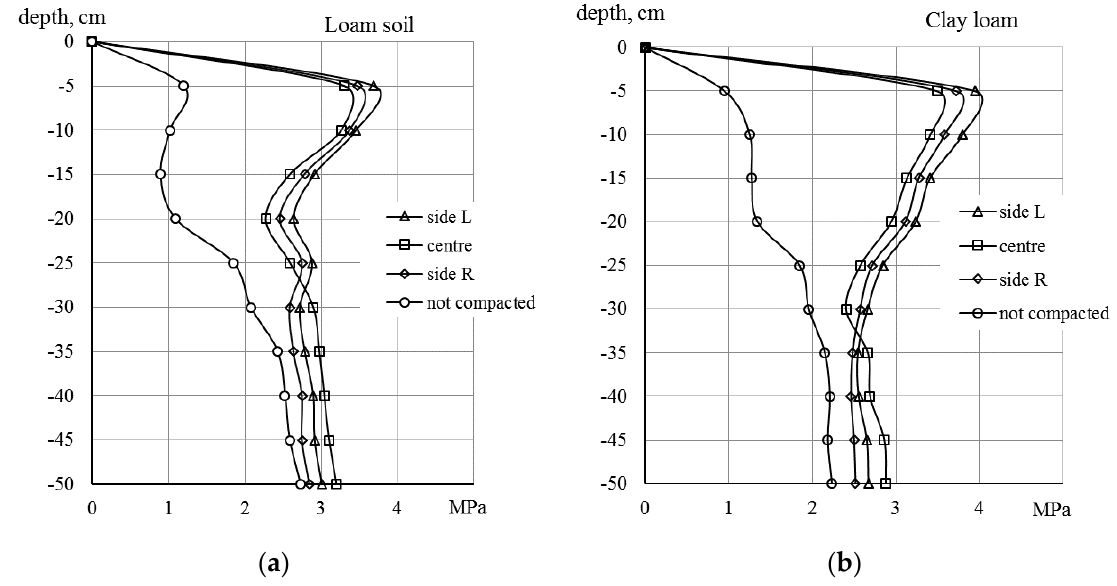
Figure 5. Soil penetration resistance on loam soil ( a ) and clay loam soil ( b ).